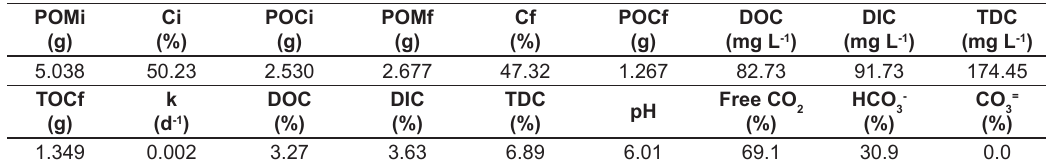
Table 1. Mass balance (average values and in carbon basis) of the Typha domingensis mineralization. POMi